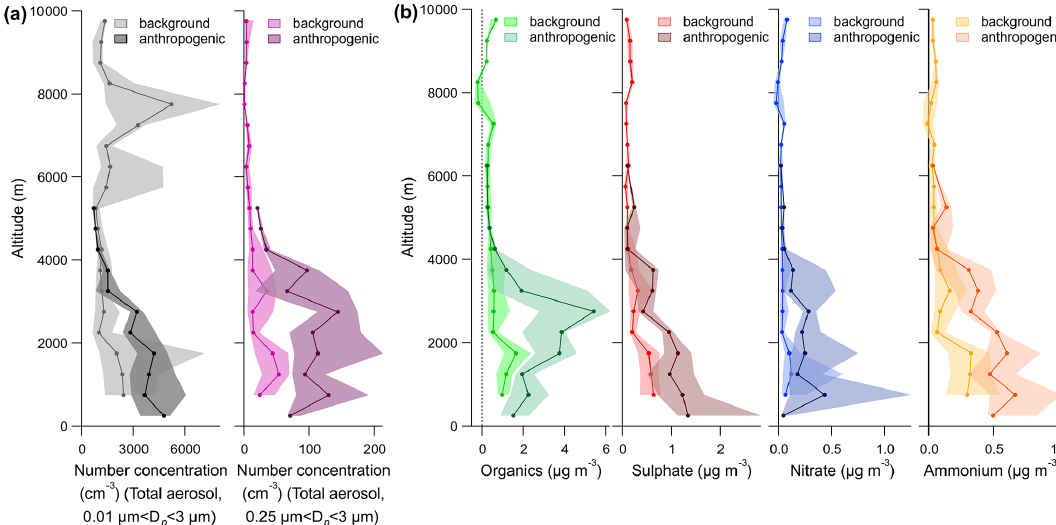
Figure 17. As in Fig. 15 but for (a) total aerosol number concentrations for two different size ranges (0.01–3 and 0.25-3µm) and (b) organic, sulfate, nitrate, and ammonium mass concentrations in the aerosol particles. The dots in the solid lines represent the medians averaged over altitude bins of 500m, and the shaded areas are the